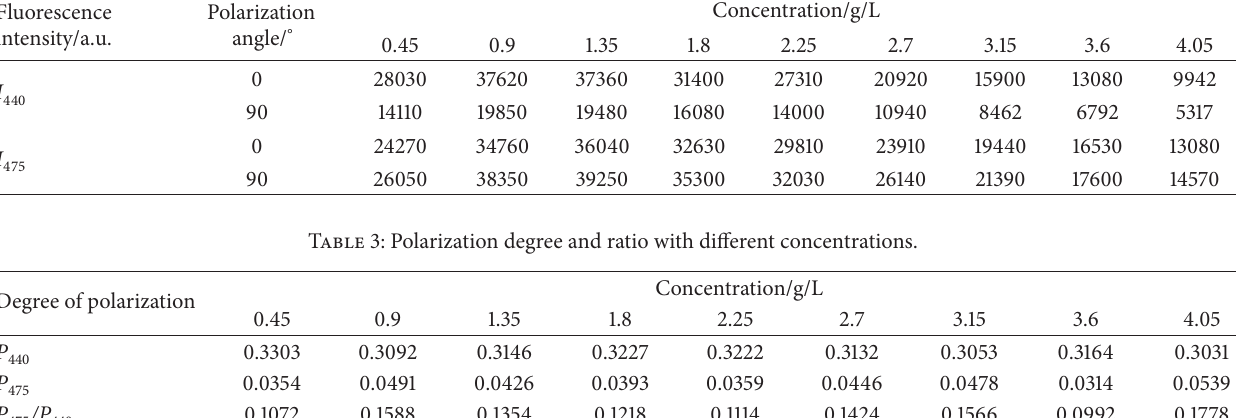
Table 2: The fluorescence peak intensities of vinegar-water solutions with the polarization angle of 0 ∘ and 90 ∘ . Fluorescence intensity/a.u.